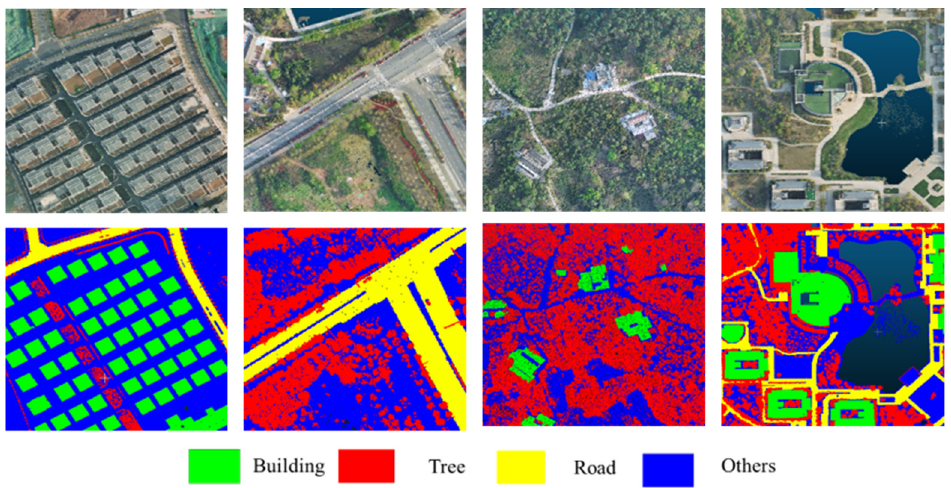
Figure 2. Examples of the NJSeg-3D dataset. Different semantic classes are labeled using different colors, where green point clouds represent buildings, red point clouds represent trees, yellow point clouds represent roads, and blue point clouds represent other objects.